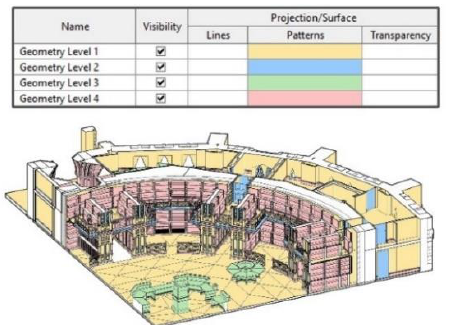
Figure 4. Revit model divided into four Geometry Levels.